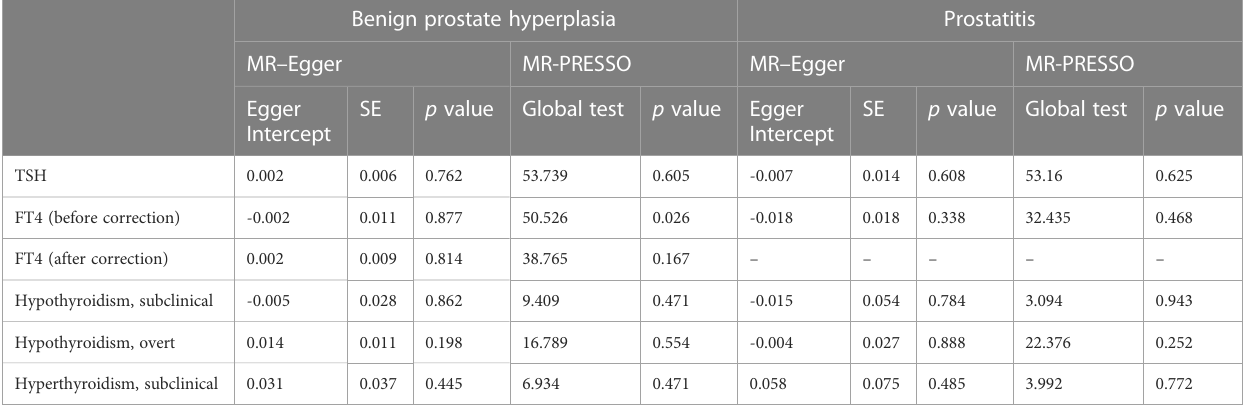
TABLE 2 Pleiotropy test in the causality of thyroid function and benign prostatic